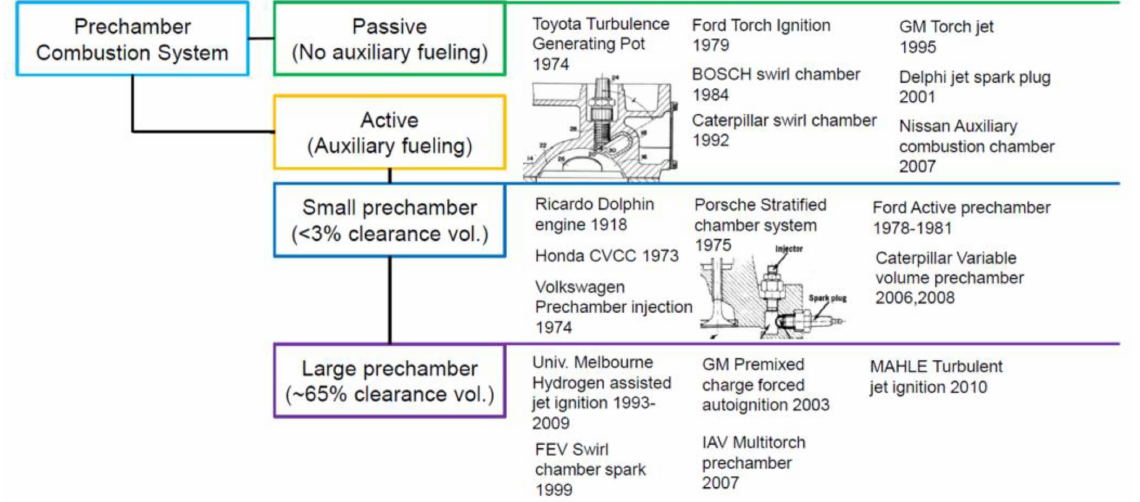
Figure 14. Research and development on the active and passive pre-chamber configurations (image redrawn from